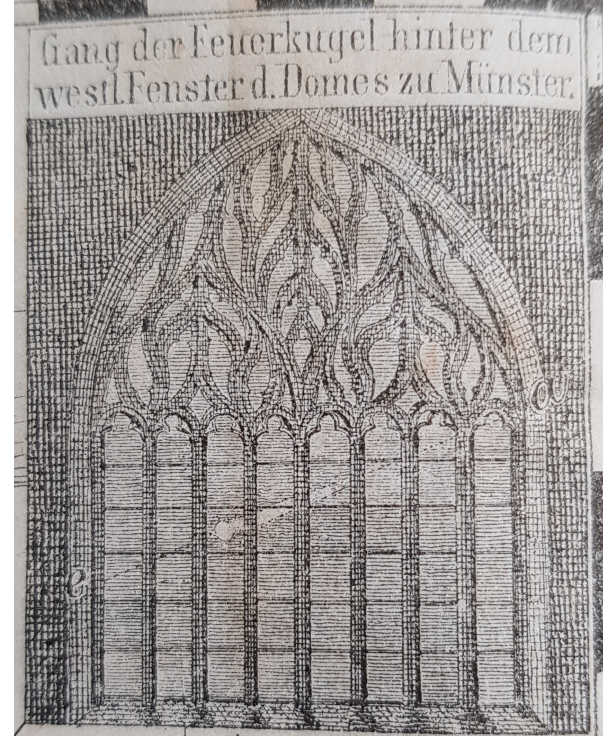
Figure 6. One of the most remarkable pictures of a fireball ob- served on 4 March 1863 through the window of the Münster cathe- dral (Heis,